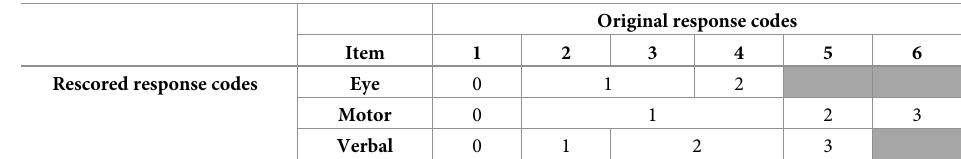
Table 4. GCS response category coding, pre- and